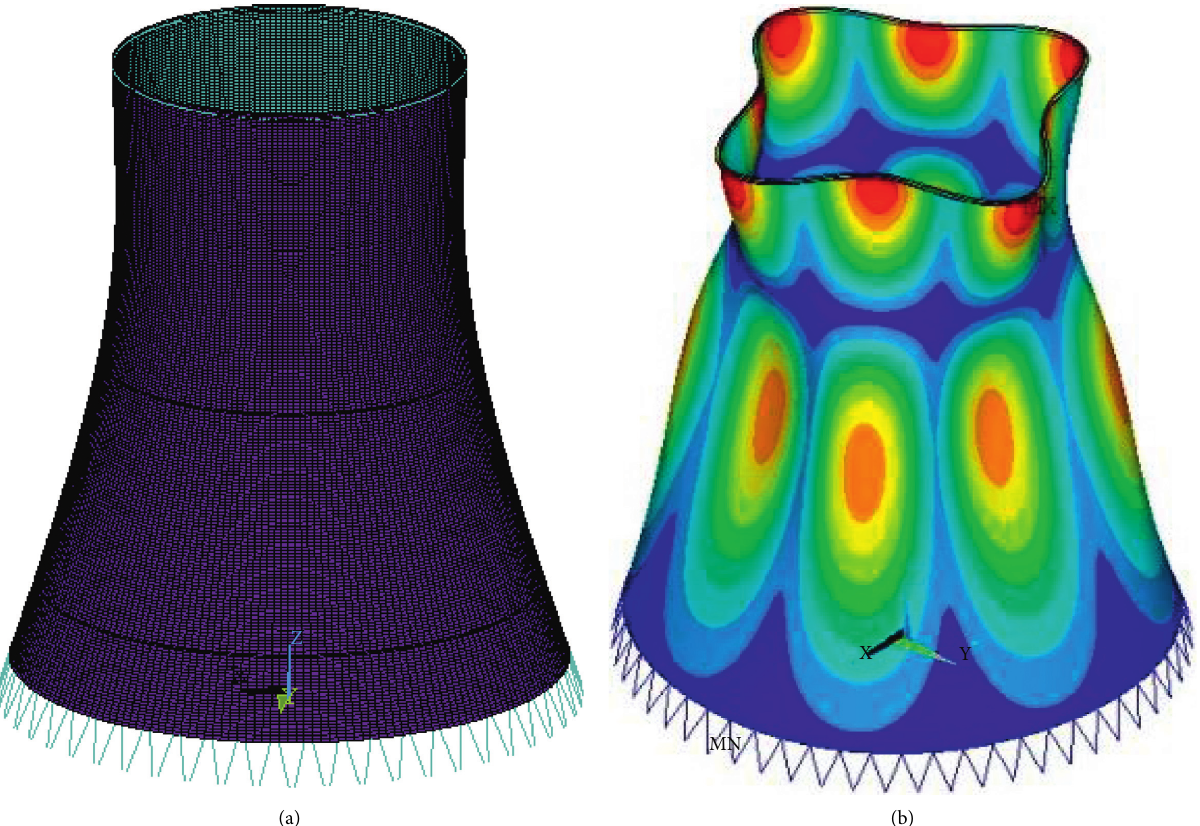
Figure 8: Finite element model and first-order modal. (a) Finite element model. (b) First-order modal ( f �